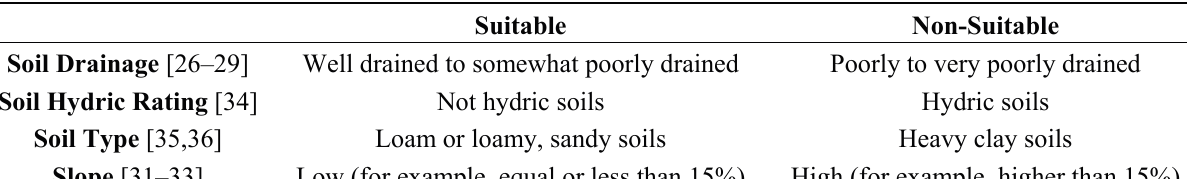
Table 1. General land suitability factors for optimal perennial energy grass yield.